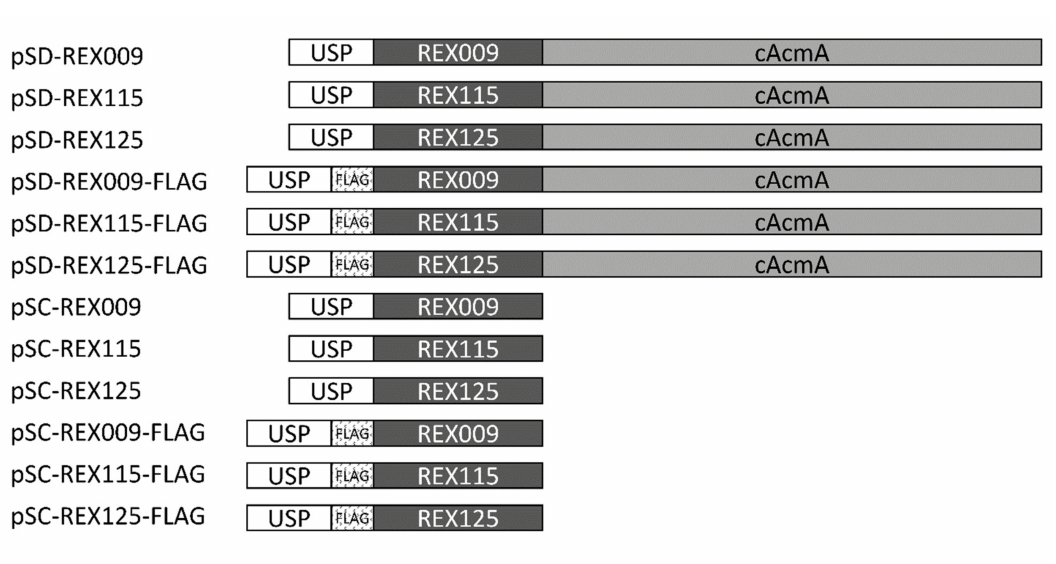
Figure 1. Scheme of genetic constructs for display (pSD) and secretion (pSC) of REX